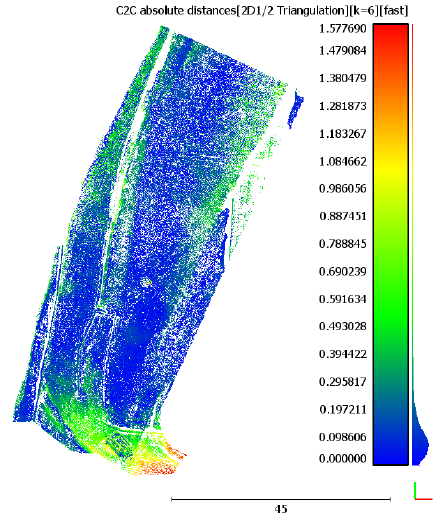
Figure 20. 3D surface deviation analysis result – the C2C distance computation values in colour scale mode